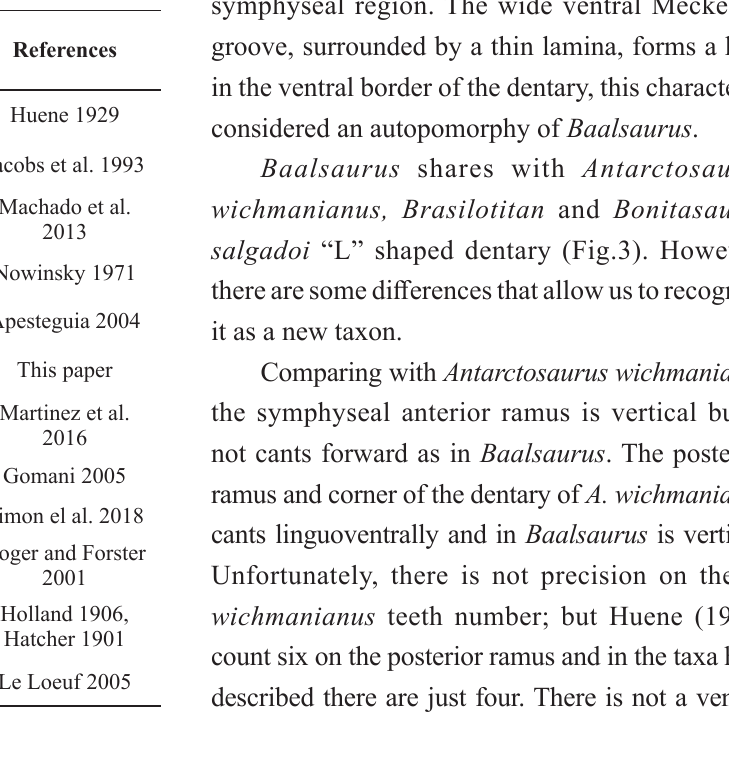
TABLE I Number of teeth present in dentaries of taxa